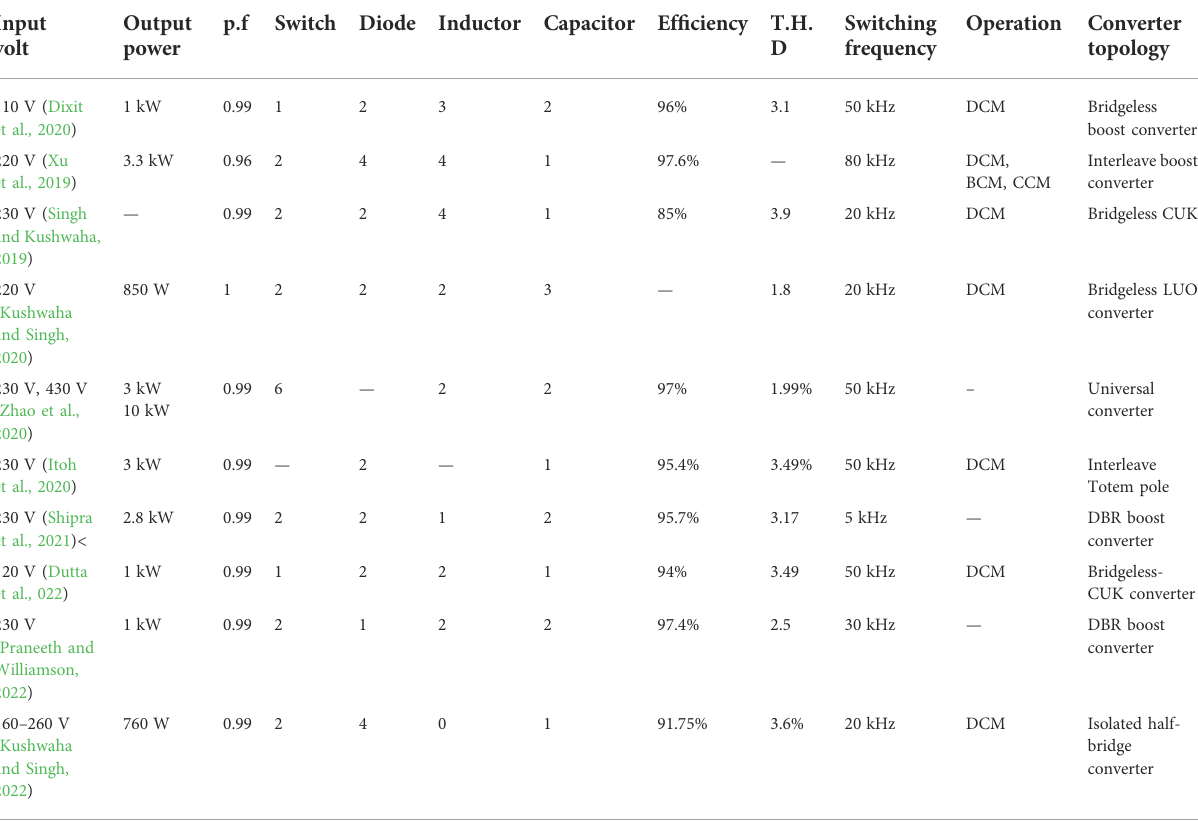
TABLE 3 PFC converter summary.